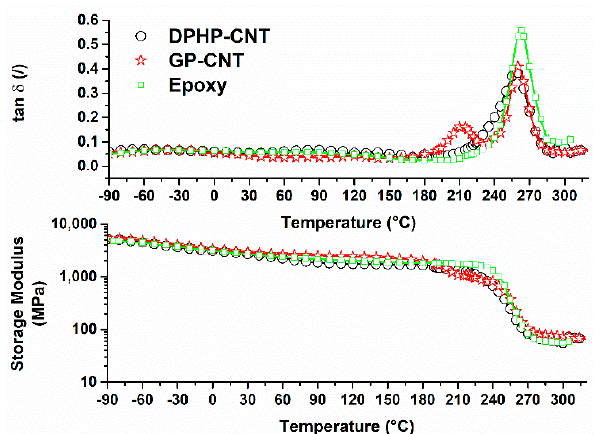
Figure 7. Results of dynamic mechanical analysis performed on cured Epoxy, DPHP-CNT/EP, and GP-CNT/EP samples.